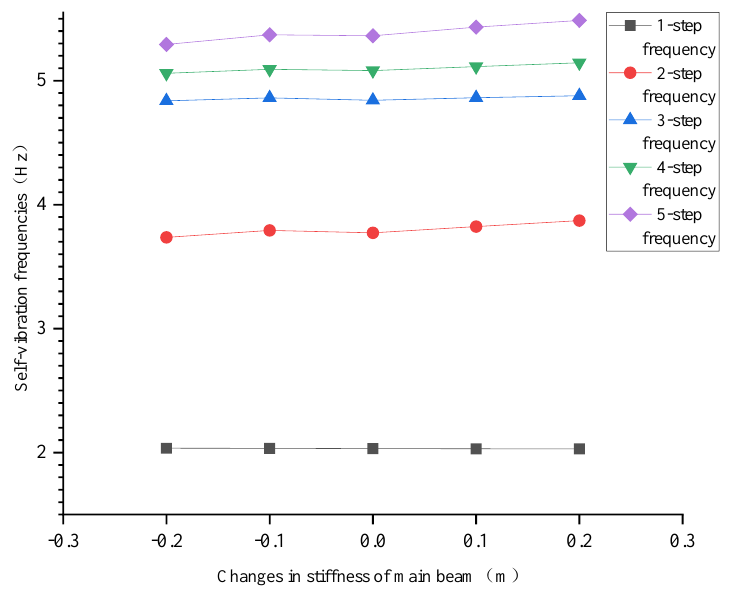
Figure 10. Self-vibration frequencies for different main beam stiffnesses of Structure II.